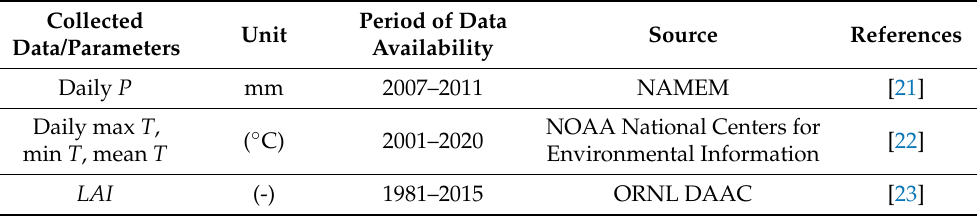
Table 1. Information (time-period, location, and reference) of data